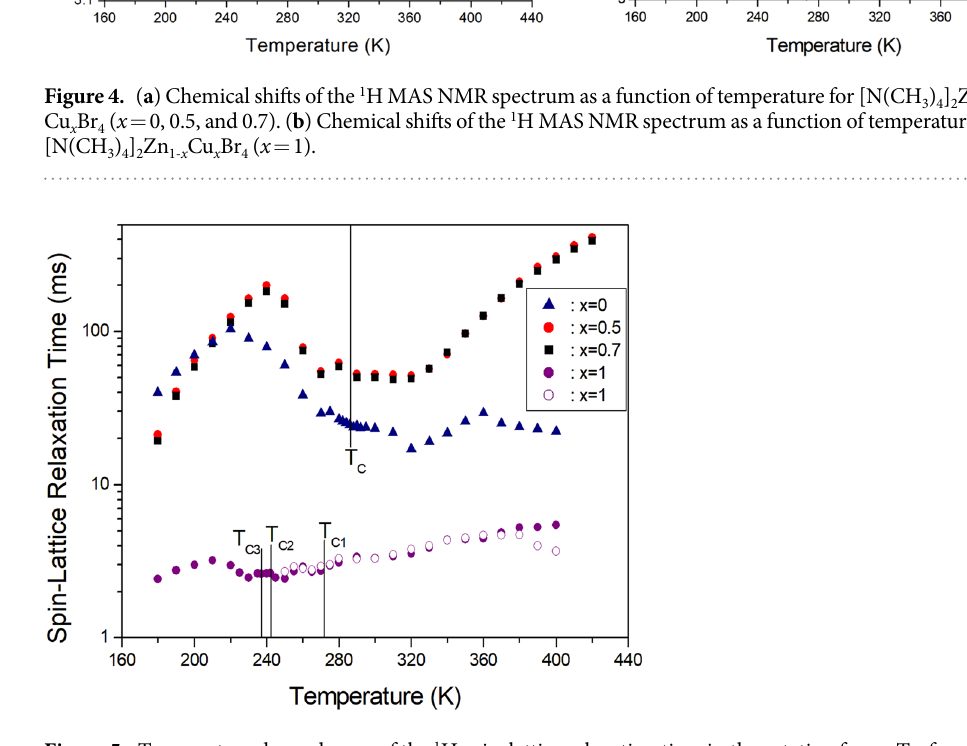
Figure 5. Temperature dependences of the 1 H spin-lattice relaxation time in the rotating frame T 1 ρ for [N(CH 3 ) 4 ] 2 Zn 1- x Cu x Br 4 ( x = 0, 0.5, 0.7, and